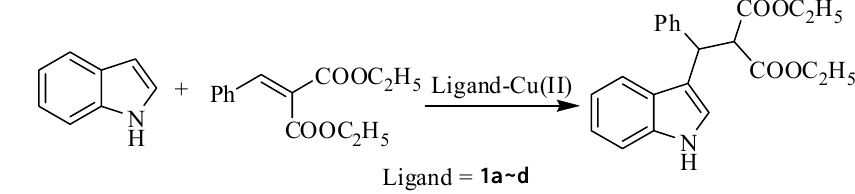
Table 1. Effect of ligands and solvent in Cu(II)-catalyzed Friedel-Crafts alkylations.